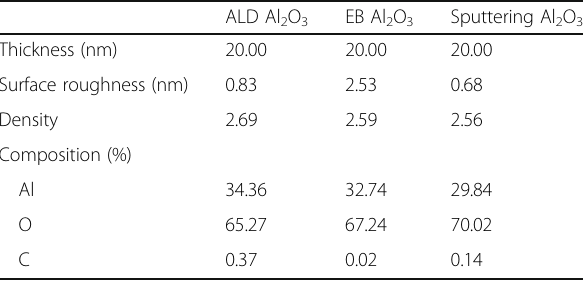
Table 1 Summary of the properties of Al 2 O 3 films deposited by different deposition